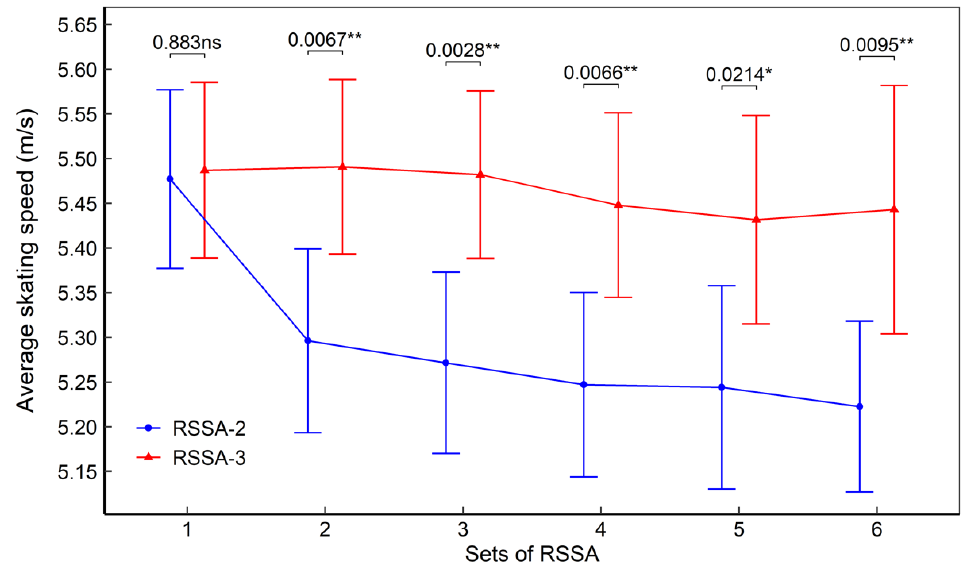
Figure 2. Average skating speed during RSSA-2 and RSSA-3 tests (ns—non-significant, ** p < 0.01; * p < 0.05).